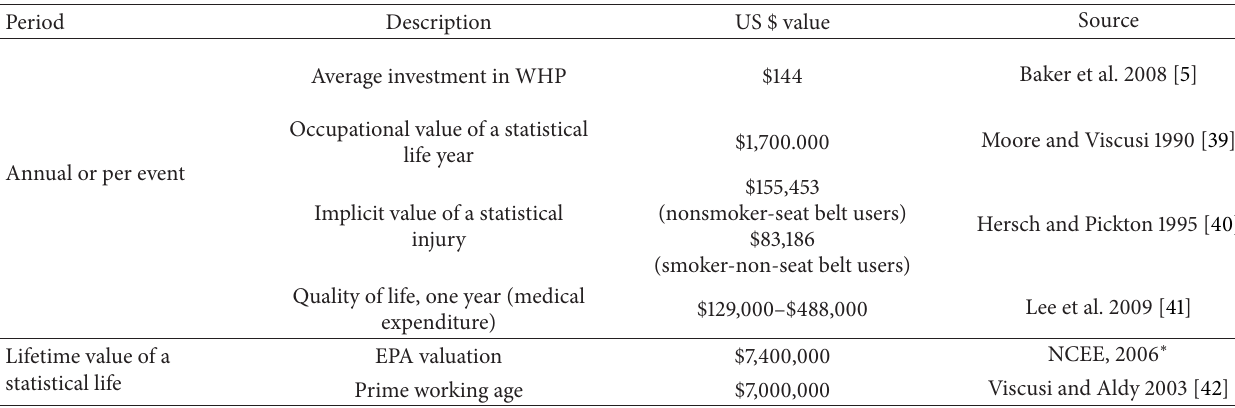
Table 3: The value of a